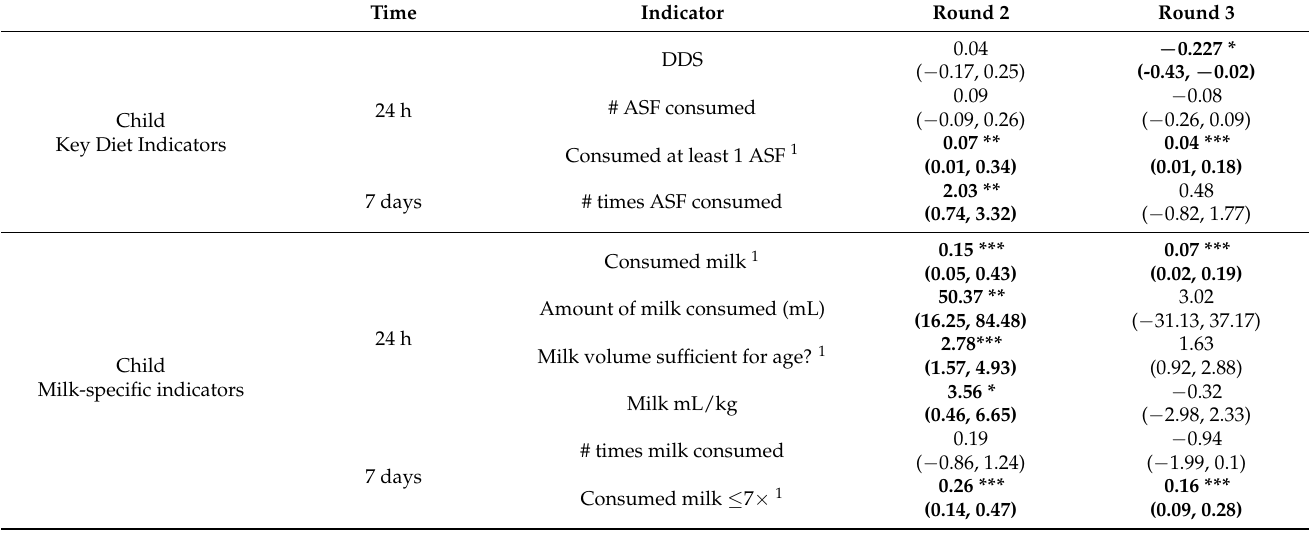
Table 3. Dietary indicators after adjustment for household and child factors. Mixed effect regressions (logistic and linear) were performed to assess the change in diet indicators over the three survey rounds. Analyses were adjusted for survey round, child (age and gender) and household (maternal education, wealth, income per capita, number of children <15 years of age). *** <0.001, ** <0.01, * <0.05; 1 Adjusted odds ratio (95%CI); † consumed by someone in the household (other than the enrolled child); DDS dietary diversity score, ASF animal source foods, # number. Bold indicates significant